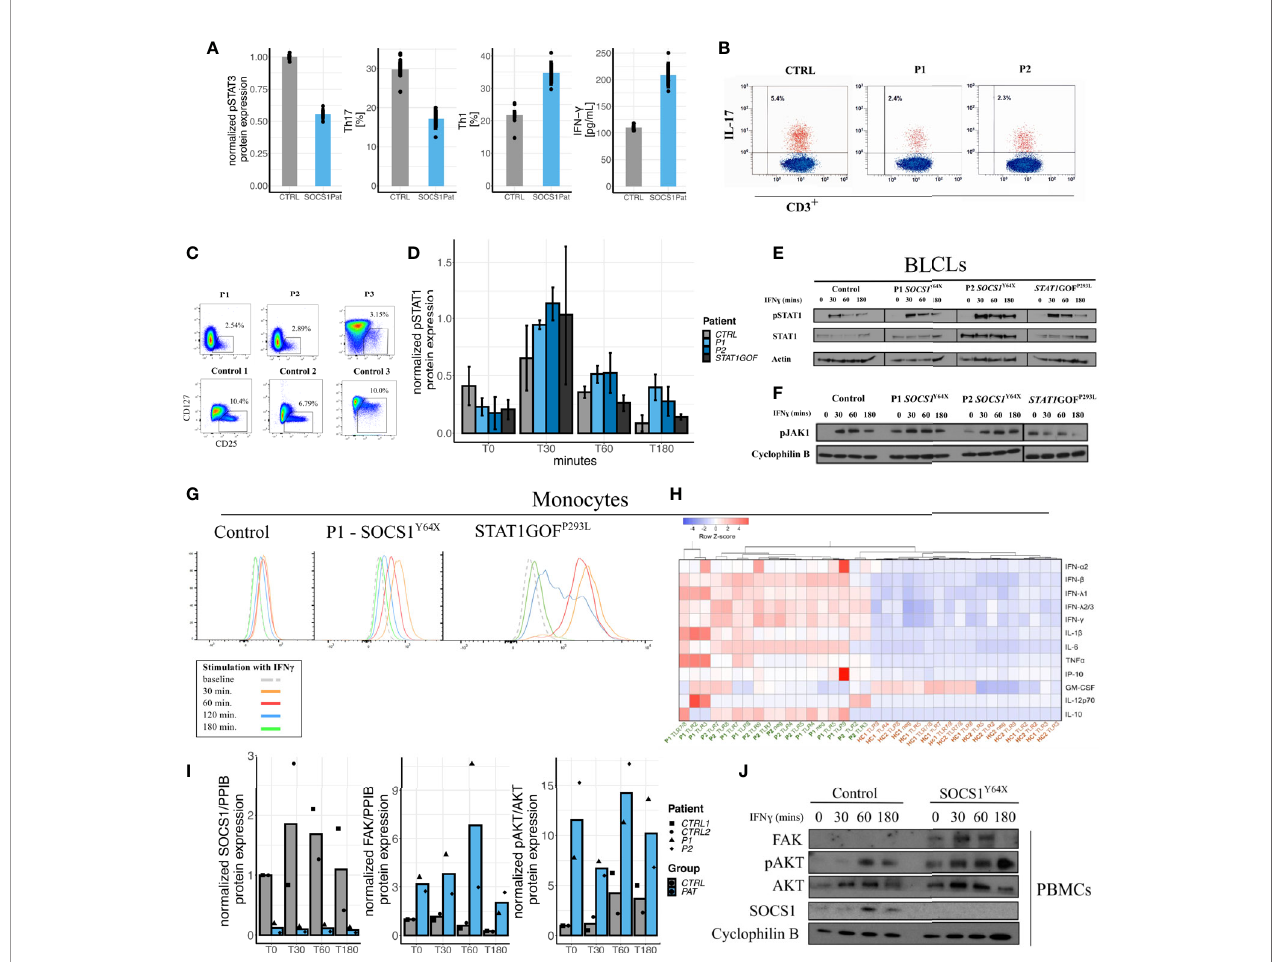
FIGURE 3 | Impact of SOCS1 haploinsuf fi ciency on immunophenotype, JAK/STAT signaling as compared to STAT GOF and intracellular signaling pathways beyond JAK/STAT. (A) Reduced pSTAT3 in SOCS1 +/- T cell blasts following IL-6 stimulation, reduced Th17 (CD3+CD4+CXCR3-CCR6+) cells in SOCS1 +/- patients, increased proportions of Th1 (CD3+CD4+CXCR3+CCR6-) cells in SOCS1 +/- patients, and increased IFN- g from CD4+ T cells in response to anti-CD3/CD28 stimulation and compared with healthy controls. (B) FACS plots of IL-17 expression in fresh T cells (CD3 + ) of P1 and P2 compared to a healthy control. (C) FACS plots of regulatory T cells (Tregs) from frozen PBMCs of P1 and P2 and fresh blood of P3 as well as three representative plots from healthy controls (published in Supplementary Material of 8). (D) Graphical expression of immunoblots of pSTAT1 from a time-course of IFN- g stimulated PBMCs of SOCS1 +/- patients and a STAT1 GOF patient (p.(Pro293Leu), located in the Coiled coil domain of STAT1). Error bars: Mean±S.E.M. (E) Immunoblots of pSTAT1 and STAT1 from an IFN- g stimulation time-course from BLCLs from SOCS1 +/- and STAT1 GOF patients. (F) Immunoblots of pJAK1 from an IFN- g stimulation time-course from BLCLs from SOCS1 +/- and STAT1 GOF patients. (G) Mean fl uorescence intensity time-course of pSTAT1 in monocytes from patients with SOCS1 +/- and STAT1 GOF . (H) Heatmap and hierarchical clustering of normalized cytokine production [log10(original cytokine concentration x) – row means (mean value of each cytokine after log10 transformation) of log10(x)] in response to TLR ligands (TLR 2-5 and TLR 7-9) in monocytes of SOCS1 +/- patients and healthy controls. (I) Quanti fi cations of immunoblots of IFN- g 20ng/ml stimulation time-course in PBMCs for SOCS1, FAK and pAKT in P1 and P2 compared to two matched healthy controls. (J) Representative immunoblot of IFN- g stimulation time-course in PBMCs for FAK and AKT in a SOCS1 +/-